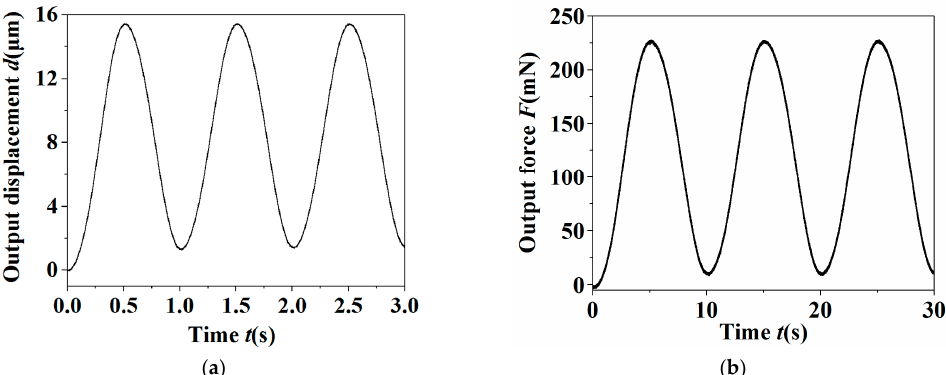
Figure 7. The output displacement and gripping force of the microgripper under a sinusoidal driving voltage. ( a ) The output displacement; ( b ) the output gripping force.